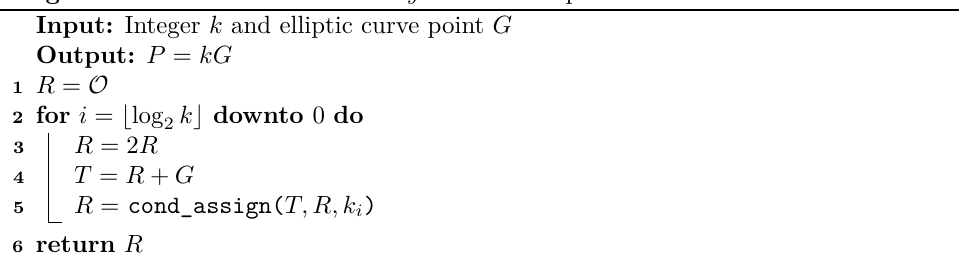
Algorithm 2: double-and-add always scalar